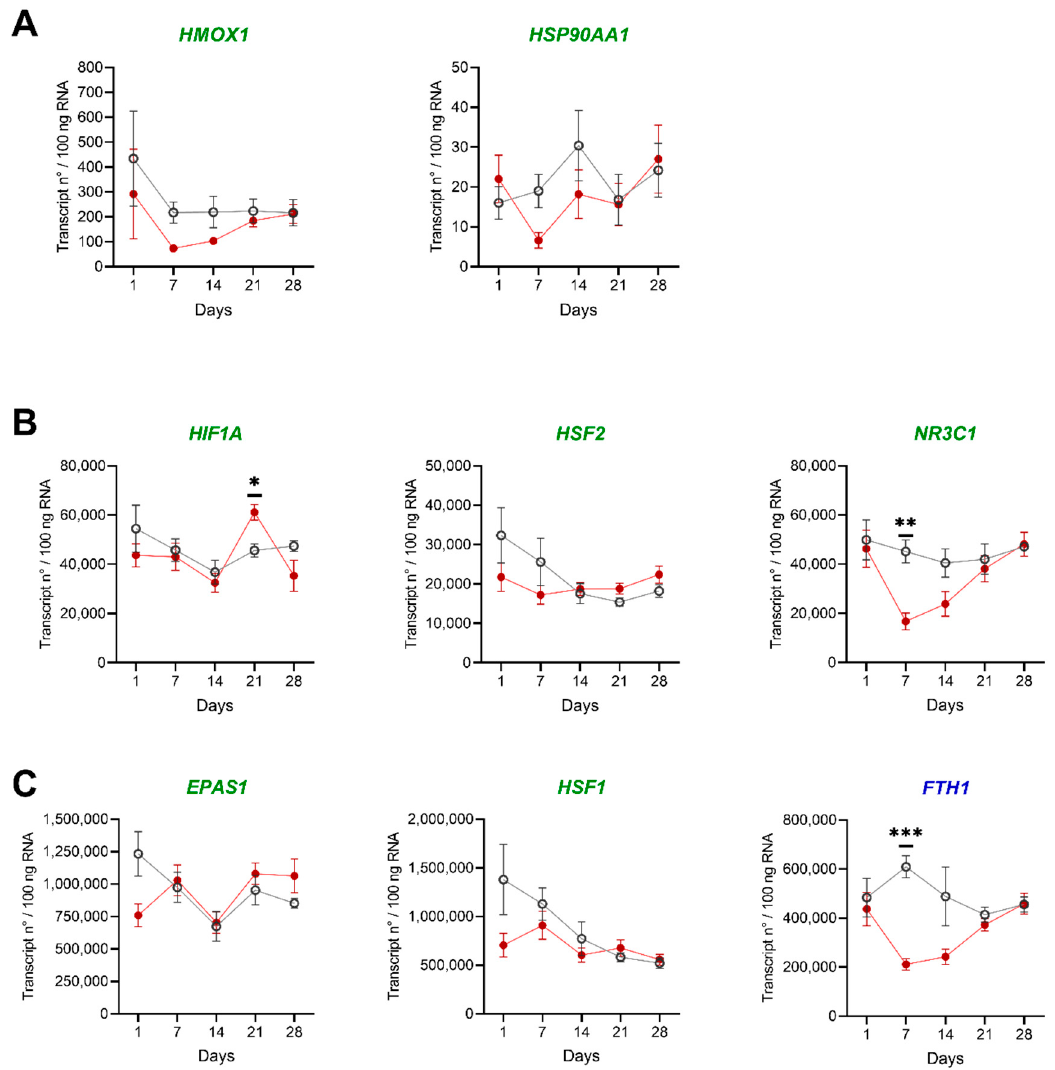
Figure 4. Stress and immune marker genes in liver of pikeperch challenged with low oxygen saturation. Gene expression of candidate genes in collected liver samples of pikeperch. Normoxic (grey/empty circles) and low DO (red/filled circles) group after one, seven, fourteen, twenty-one and twenty-eight days of the experiment. Genes involved in stress (green) or immune response (blue) are either lowly ( A ), moderately ( B ) or highly ( C ) expressed. Data points represent the mean of five individual samples (+SEM), calculated per 100 ng of total RNA. Statistical significance was determined between groups for each day using the multiple t-test (Holm–Šídák corrected), with alpha = 0.05; * < 0.05, ** < 0.01 and *** < 0.001.